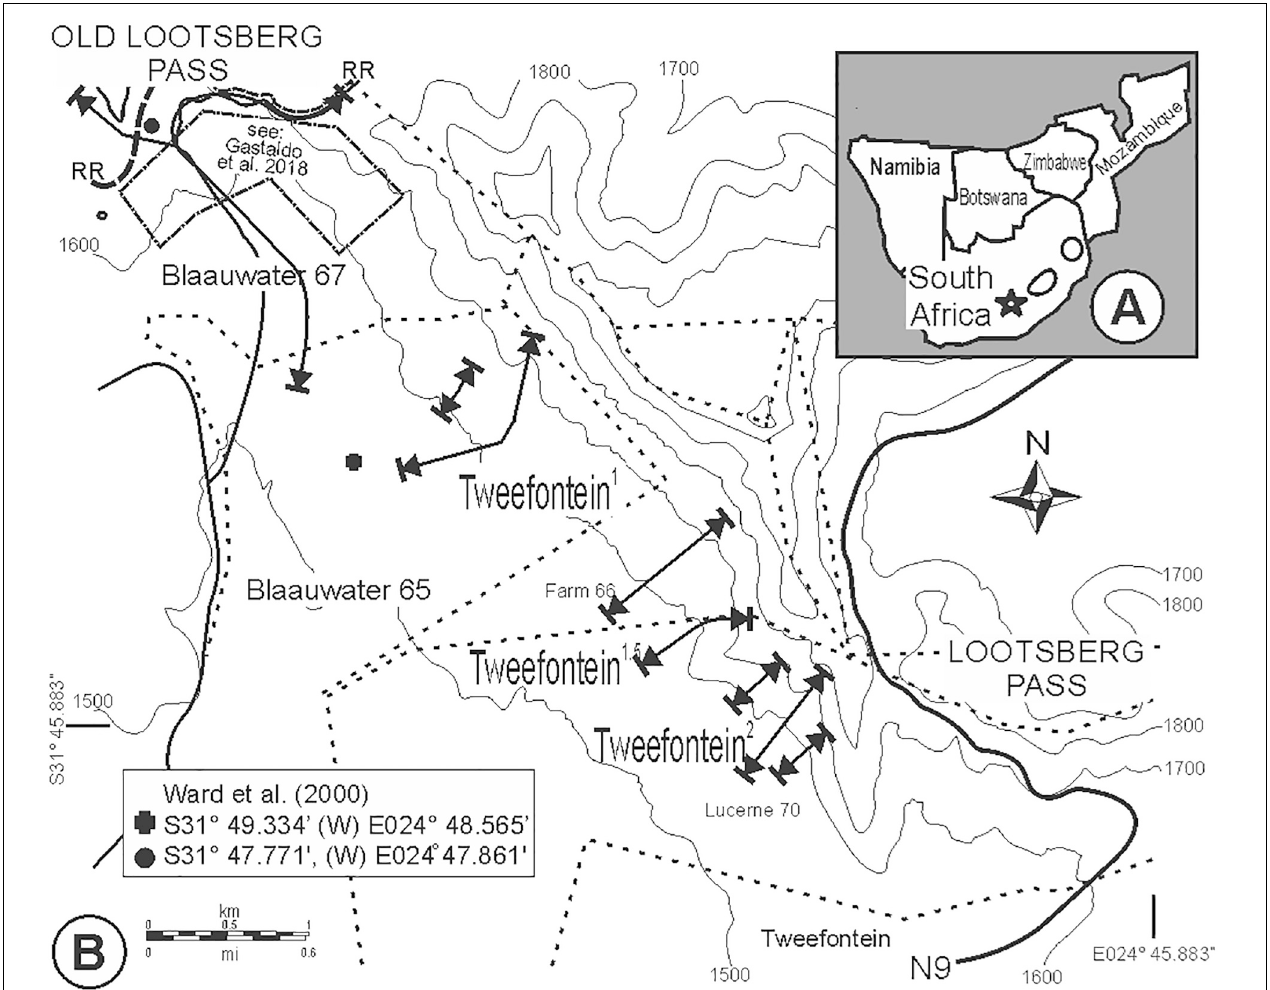
FIGURE 2 | Locality maps for the current study. (A) Generalized geographic map of southern Africa highlighting the study site in the Eastern Cape Province with a star. (B) Five localities in the Eastern Cape Province–Old (West) Lootsberg Pass, Tweefontein 1 (Gastaldo et al., 2017), Tweefontein 1 . 5 (reported here), Tweefontein 2 (refers to the section measured in an erosional gully closest to the vertebrate fossil assigned to Tweefontein by Smith and Botha-Brink, 2014), and Lootsberg Pass–reported as foundational to the terrestrial, end-Permian extinction model (Ward et al., 2000, 2005; Smith and Botha-Brink, 2014). Eight of the eleven measured stratigraphic sections used in the current study to develop a stratigraphic framework for the area are represented by solid black lines with arrows marking the base and top. GPS coordinates for the base and top of each are provided in Figure 4 . Dotted lines mark former farm boundaries with names as they appear on with the 3124DD Lootsberg 1:50,000 map which, currently, are owned by Justin and Liesl Kingwill, Blaauwater Farm. Published GPS coordinates for Old (West) Lootsberg Pass (solid circle) and Tweefontein (solid polygon) sections (Ward et al., 2000), corrected for longitude, are plotted. The published Tweefontein fossil localities (Smith and Botha-Brink, 2014) are > 3 km to the southeast of the published GPS coordinates, and appears here as Tweefontein 2 . Scale in km and mi; contour interval 100